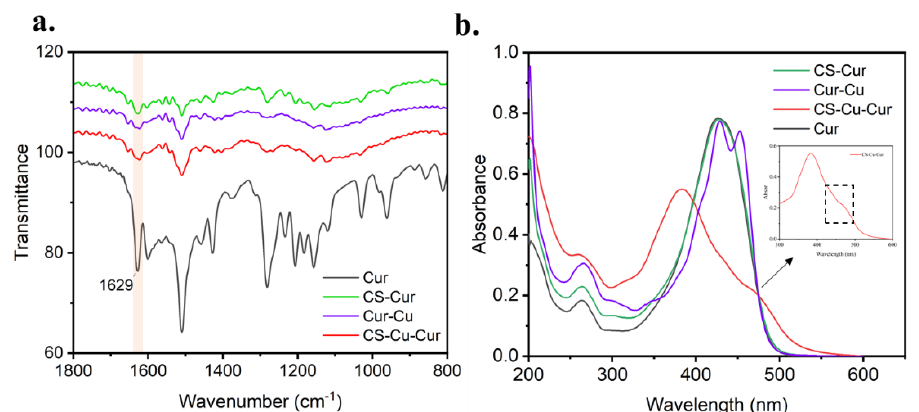
Figure 4. ( a ) Fourier transform infrared spectroscopy (FT-IR) and ( b ) UV-vis absorption spectra of CS-Cur, Cur-Cu, Cur-loaded CS nanocomplex, Cur and CS-Cu.